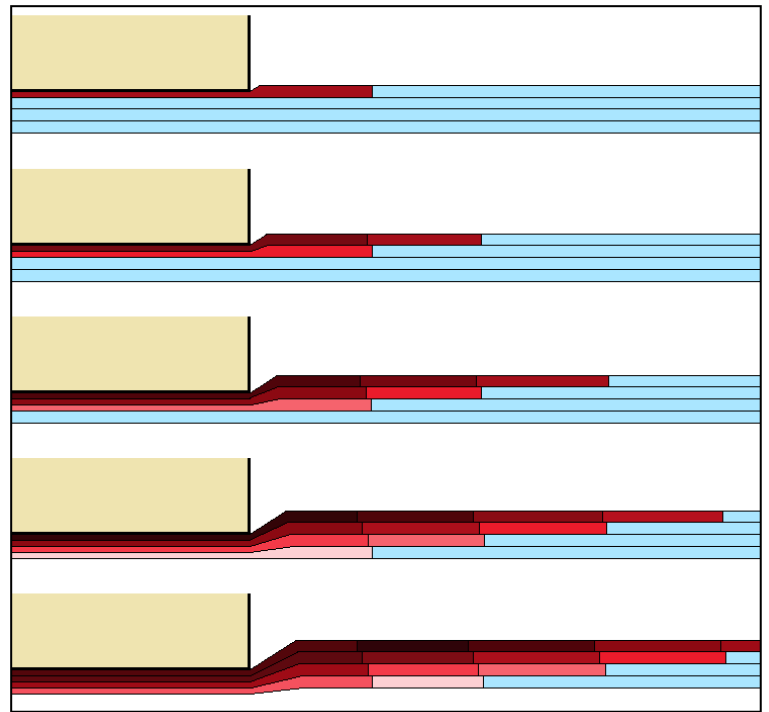
Figure A1. Flat surface (RCC) projectile distortion process in the impacted yarn in the first few microseconds after impact (ignoring the effect of tensile wave collision under the projectile).